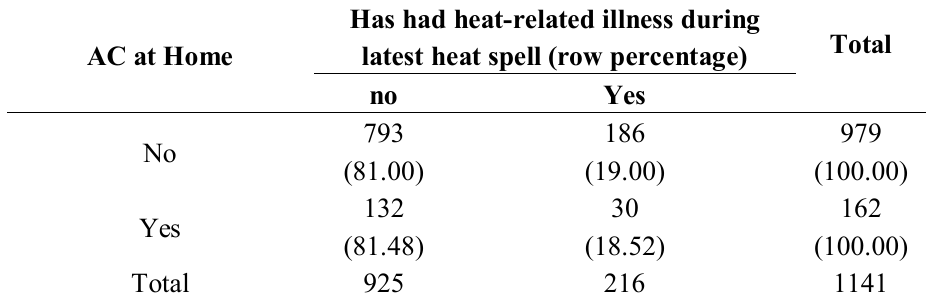
Table 13. Heat-related illness and availability of air conditioning at home.